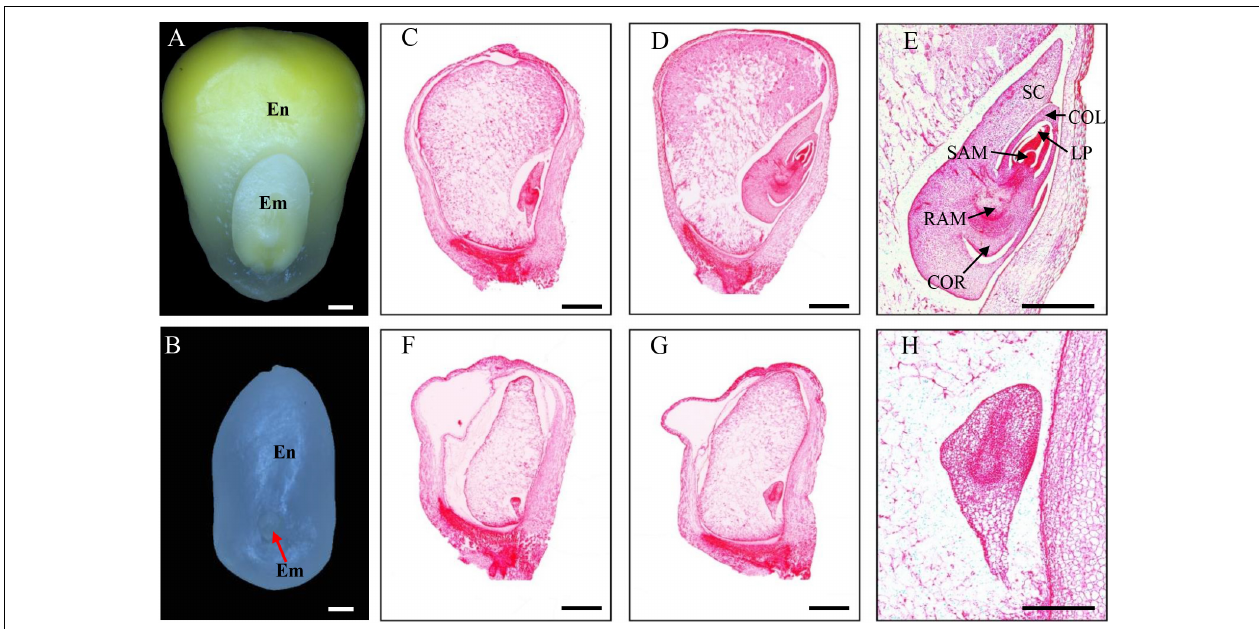
FIGURE 3 | The emp17 mutation arrests maize embryogenesis and endosperm development. (A,B) The embryo (Em) and endosperm (En) of the wild type (A) and emp17 (B) at 14 days after pollination (DAP). (C–H) Paraffin section of WT (C–E) and emp17 (F–H) developing kernels. (C,F) 10 DAP; (D,E,G,H) 14 DAP. SC, scutellum; COL, coleoptile; LP, leaf primordia; SAM, shoot apical meristem; RAM, root apical meristem; COR, coleorhiza. Bars = 1 mm in (A–D,F,G) and 500 µ m in (E,H)